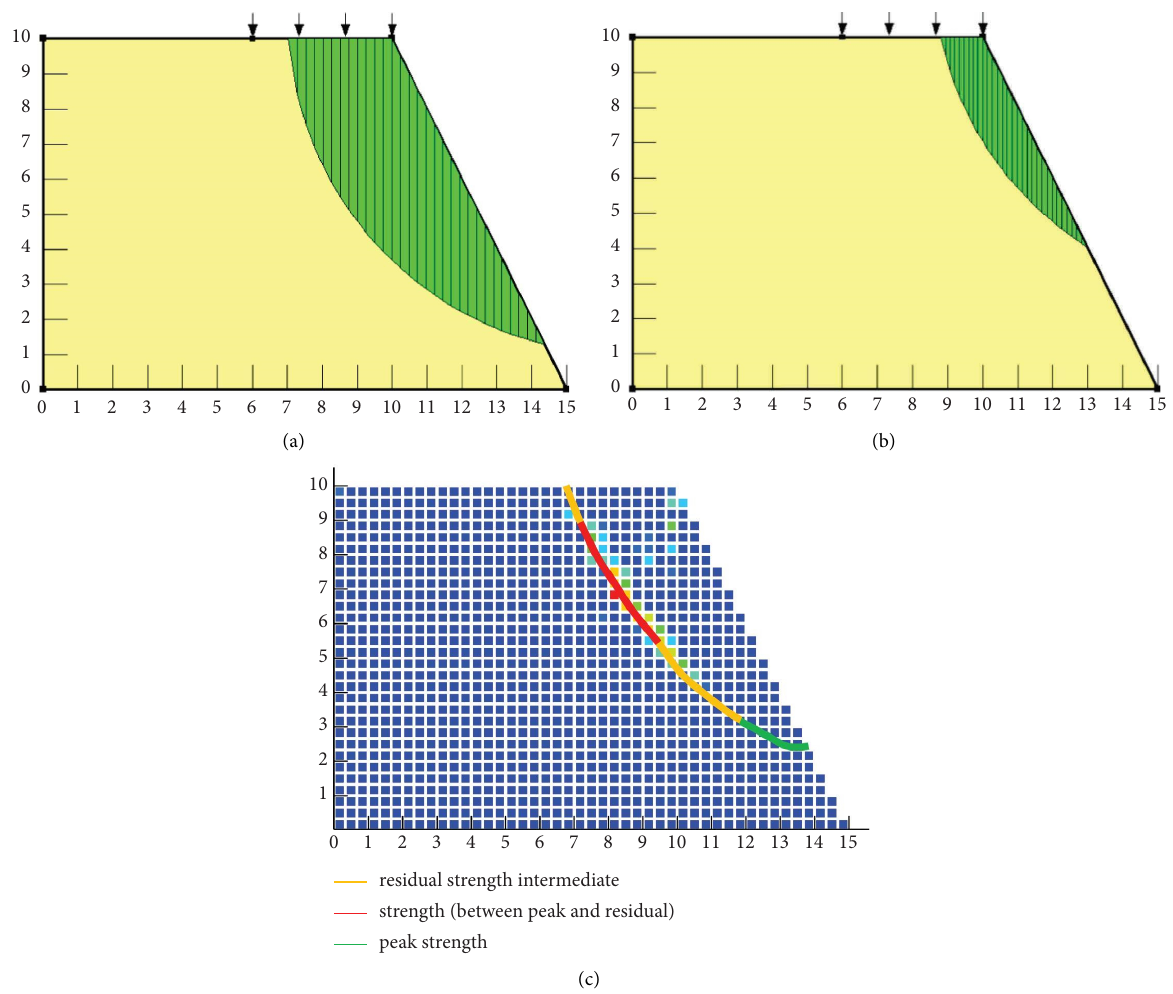
Figure 11: Slip surfaces obtained from the limit equilibrium method (LEM) and NOSBPD: (a) slip surface obtained by LEM using the peak strength parameters; (b) slip surface obtained by LEM using the residual strength parameters; (c) slip surface obtained by NOSBPD with a nonuniform mobilization of soil